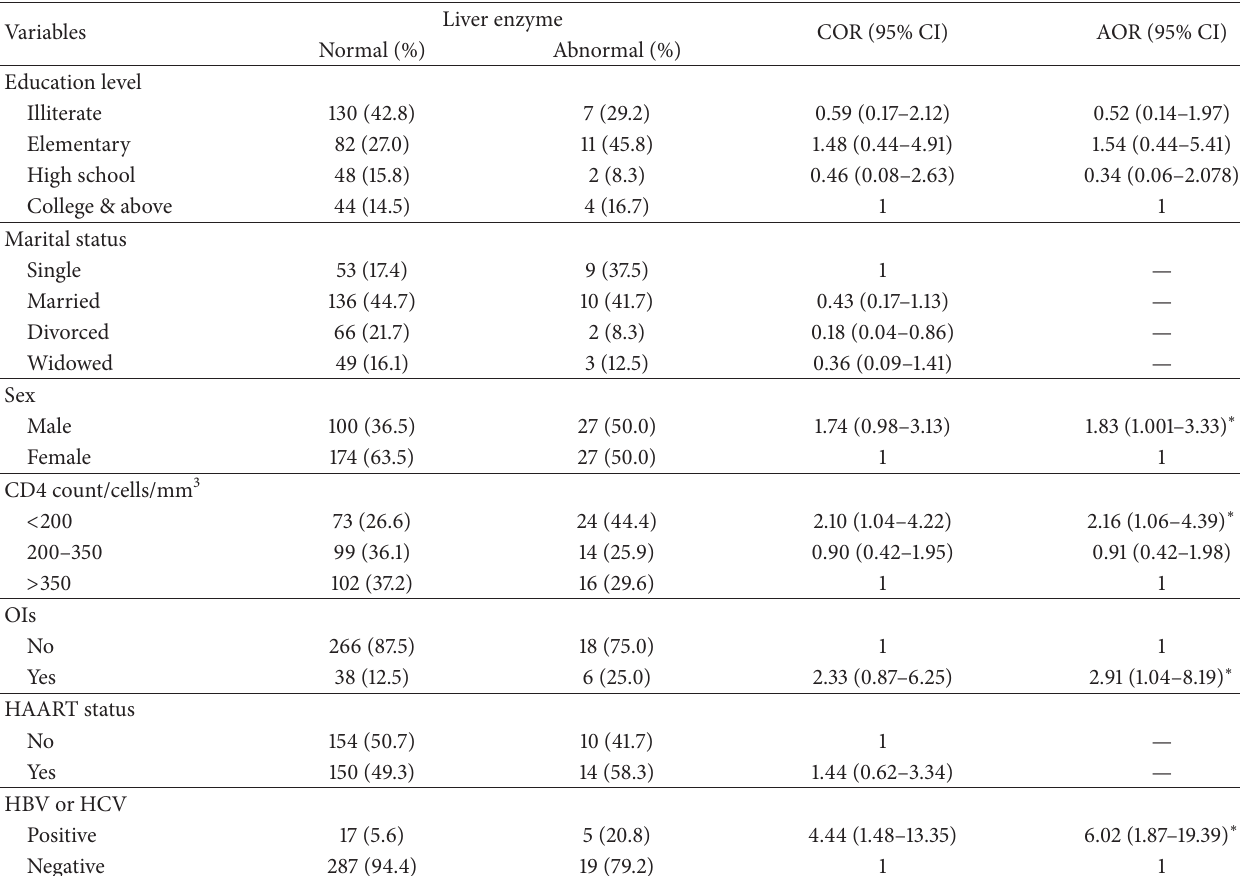
Table 3: Multiple logistic regression analysis of factors for ALT and/or AST enzyme abnormalities in HIV-1 infected patients at Debre Tabor Hospital,